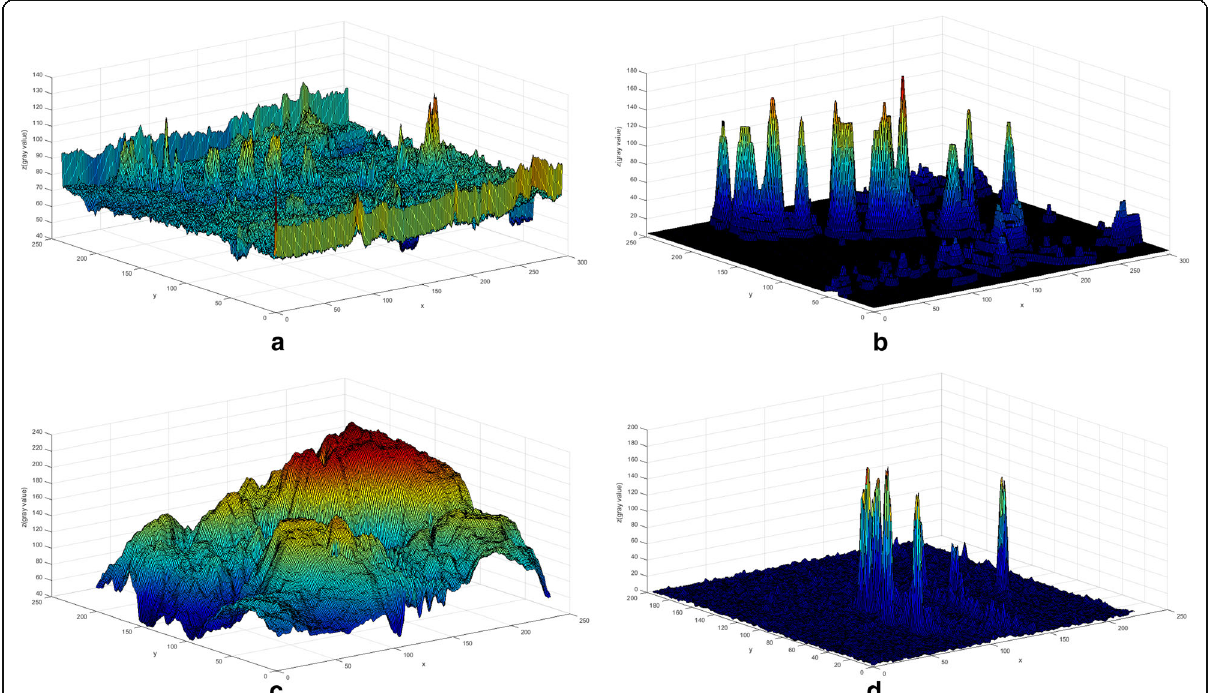
Fig. 2 The three-dimensional expression of visual saliency for infrared image and visible light's. a Infrared vehicle image. b Visual salient map for a . c Visible light plane image. d Visual salient map for